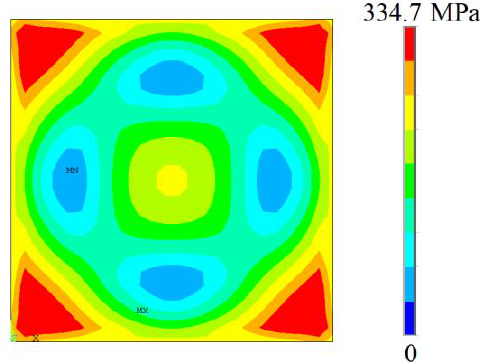
Figure 13. The von Mises stress distribution for the non-hole square plate.